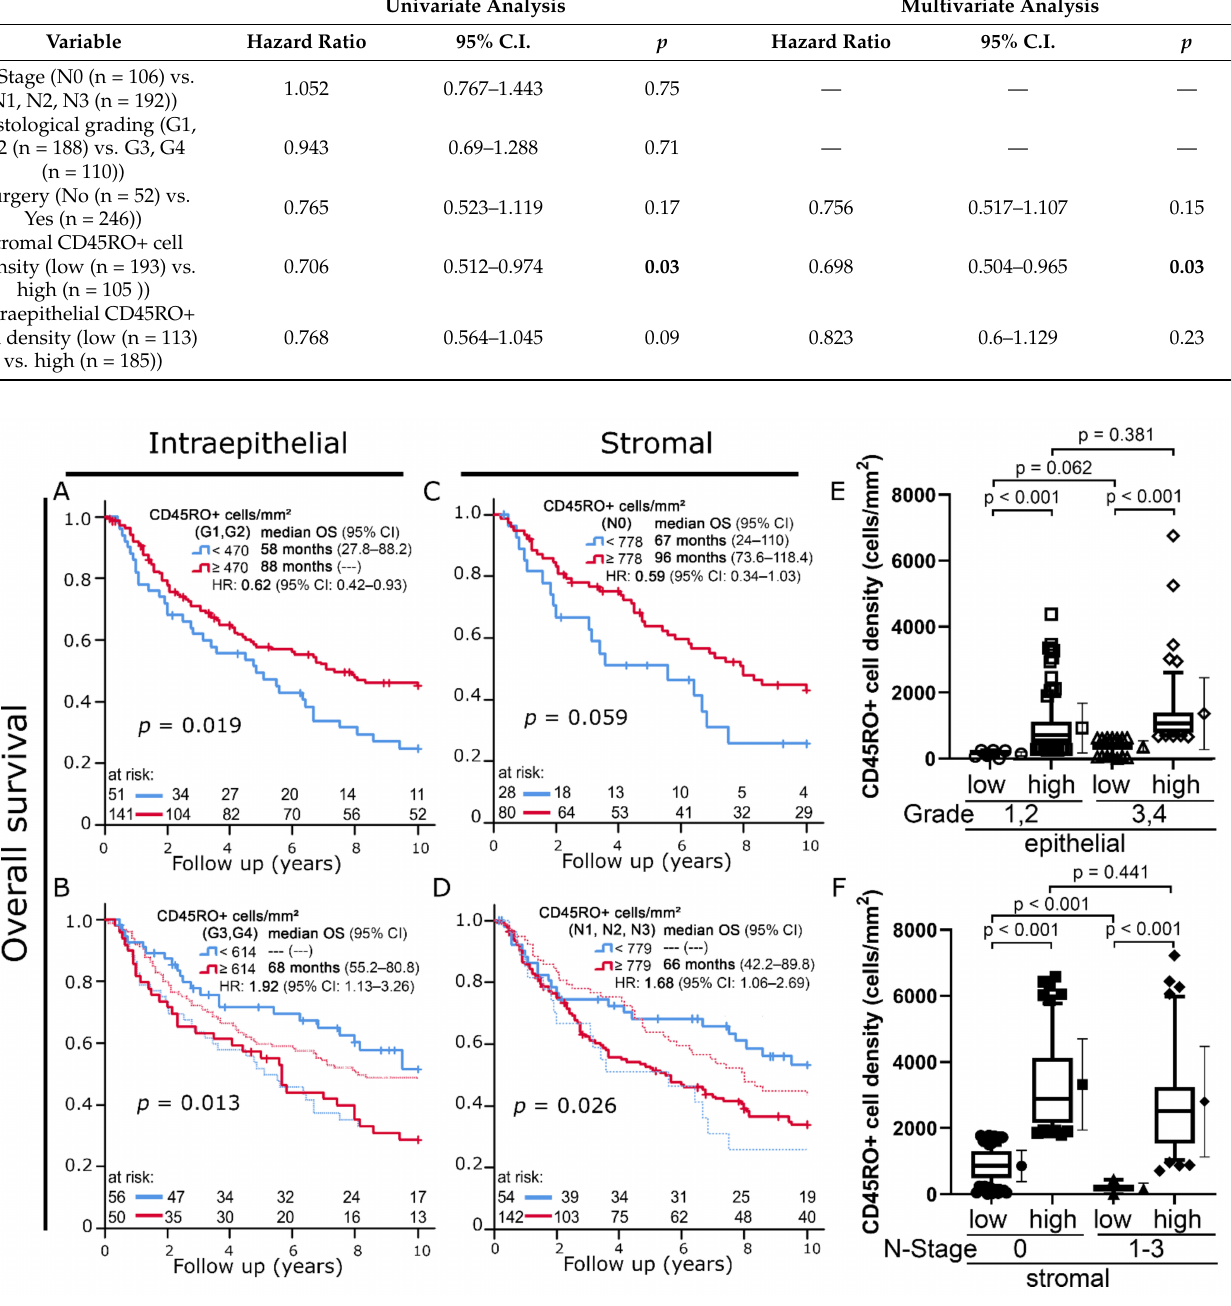
Figure 4. ( A , B ) Kaplan–Meier plots of 10-year overall survival according to intraepithelial CD45RO+ cell densities in (A) low-grade (G1, G2) versus ( B ) high-grade (G3, G4) tumors. ( C , D ) Kaplan–Meier plots of 10-year overall survival according to stromal CD45RO+ cell densities in patients with ( C ) no lymph node involvement (N0) versus patients with ( D ) positive lymph node status (N1-3). To allow a direct comparison, faded versions of the respective survival curves from ( A , C ) were included in ( B , D ). ( E ) Boxplots of intraepithelial CD45RO+ cell densities in the prognostic groups defined in ( A , B ). ( F ) Boxplots of stromal CD45RO+ cell densities in the prognostic groups defined in ( C , D ). Student’s t -test was used to compare